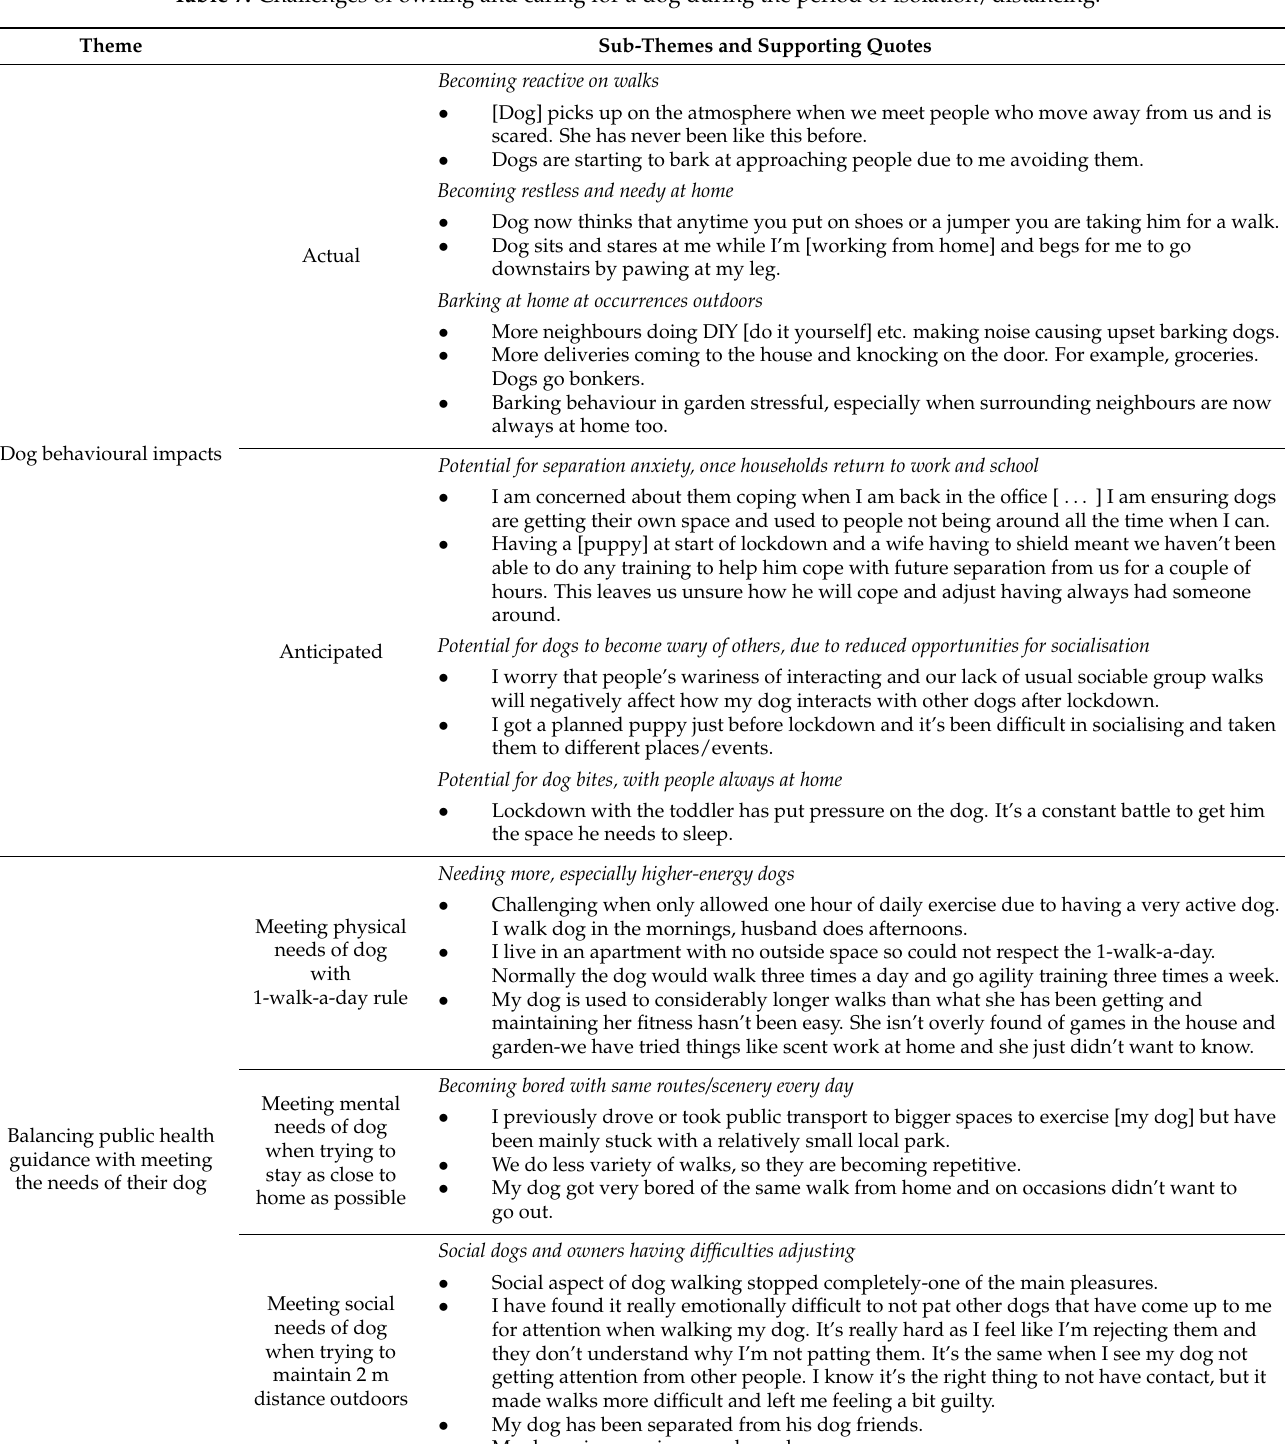
Table 7. Challenges of owning and caring for a dog during the period of